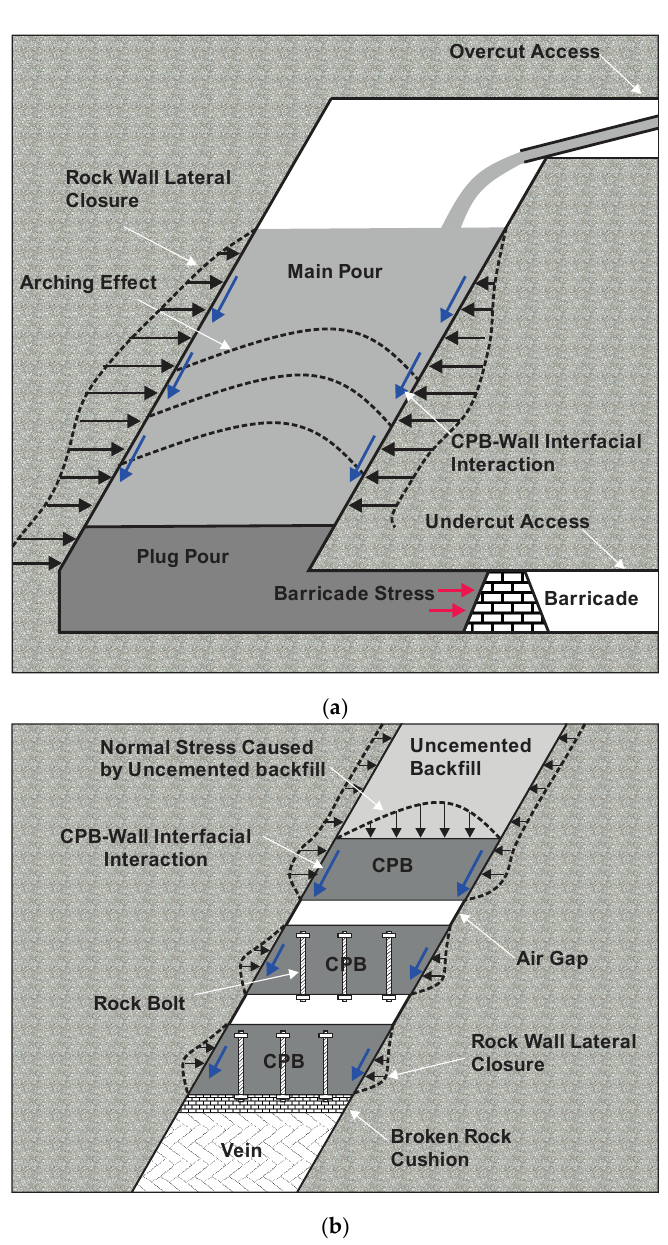
Figure 1. Mining scenarios involving undercutting previously placed backfill: ( a ) a “plug” or “sill mat” in a tall stope such as used in long hole mining; ( b ) a backfilled stope in Underhand Cut and Fill mining .